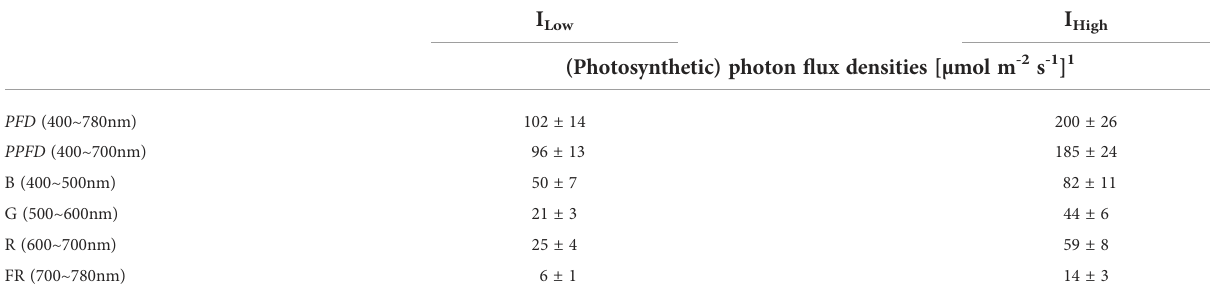
TABLE 1 Spectral compositions of the white broad-band LED light spectra 1